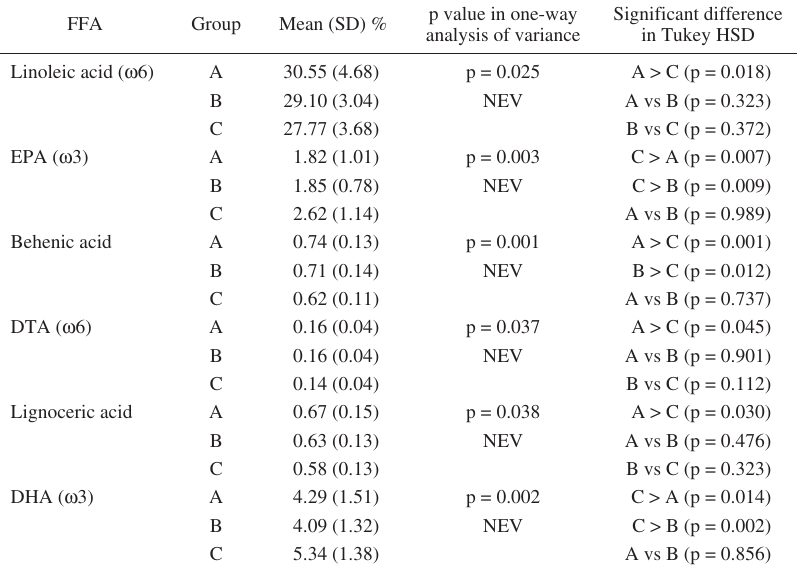
Table 2. The percentage of all fatty acids of EPA and fatty acids was significantly different between age groups.